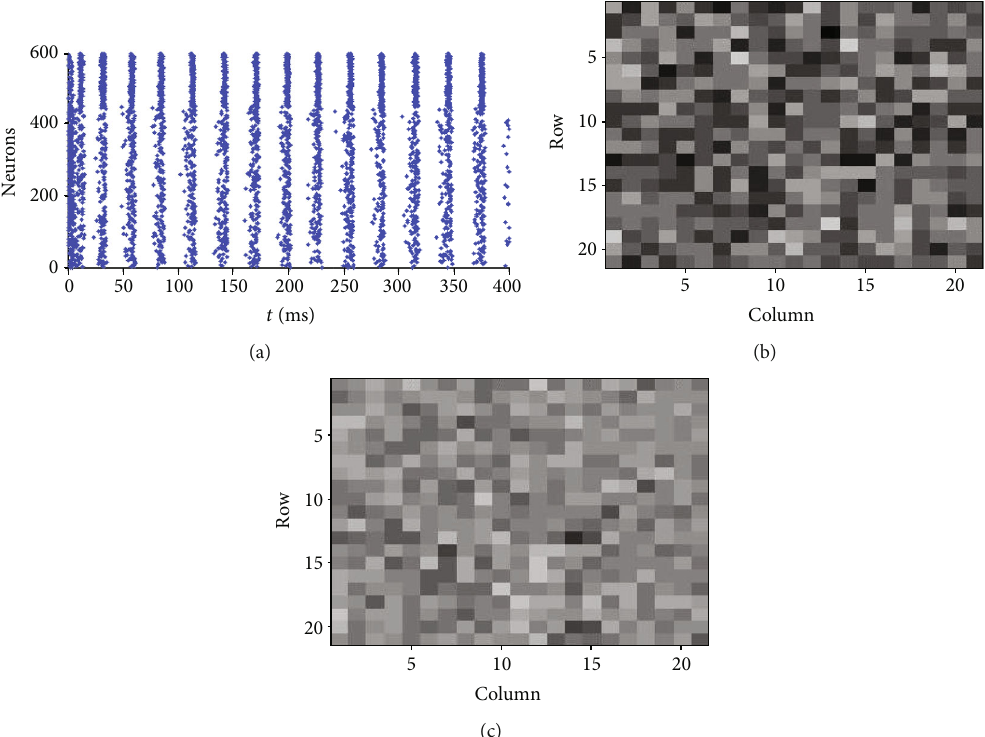
Figure 8: Firing rate contrast enhancement in a randomly connected E/I network: (a) raster plot of the fi ring of all neurons; (b) visualization of the fi ring rates of neurons 1-400 in the E/I network; (c) visualization of the fi ring rates of neurons 1-400 in a population of isolated neurons. ρ = 0 : 7 , δ B = 0 : 1 , σ B = 0 : 5 , τ E = 20 ms , τ I = 5ms , g EI = g EI = 3/ ð N N d d and m S = 3 . The other parameters are set the same as those in Figure 5.